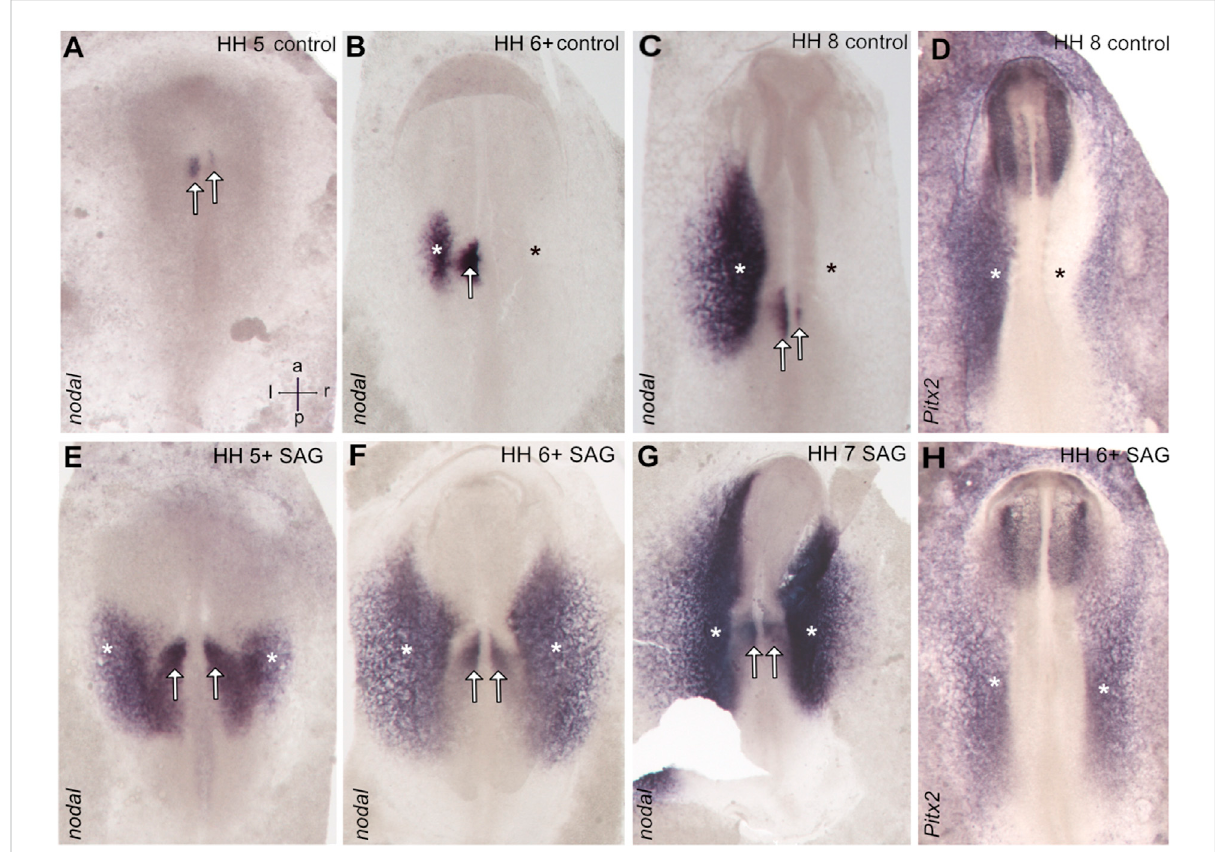
FIGURE 1 Symmetricalexpressionofmarkers ofleft – rightpatterningbetweenstages5and7inthechickembryostreatedwiththeactivatorofhedgehog signaling SAG. In control embryos, nodal expression is con fi ned to the left-sided domains close to the posterior midline (paraxial domain) and in the areaofthelateralplatemesoderm (A – C), while treatedembryosreveal bilateralexpression. (E – G) Similarly, pitx2 reveals intreated embryos bilateral expression in the lateral plate mesoderm. (H) , while control embryos reveal left-sided expression in this domain (D) . Asterisks indicate the position of the lateral plate mesoderm, arrows the paraxial domain, and intersecting arrows anatomical